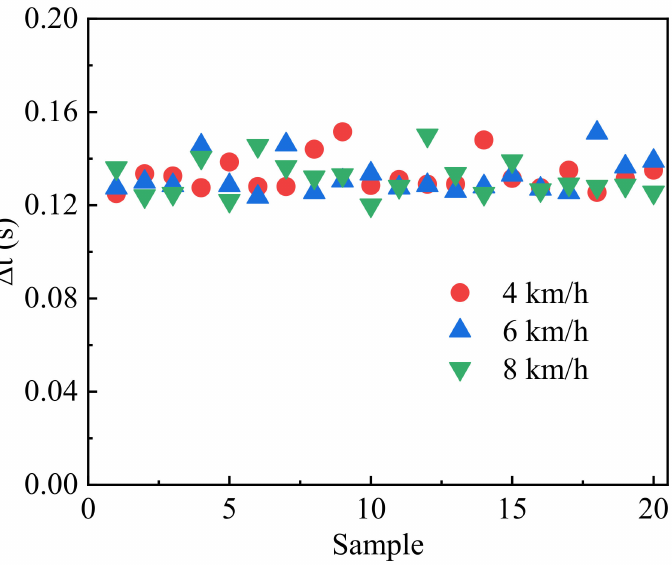
Figure 11. The time required for the seeds to fall form the photoelectric sensor to the seed bed ( ∆ t ) of 20 samples at different forward